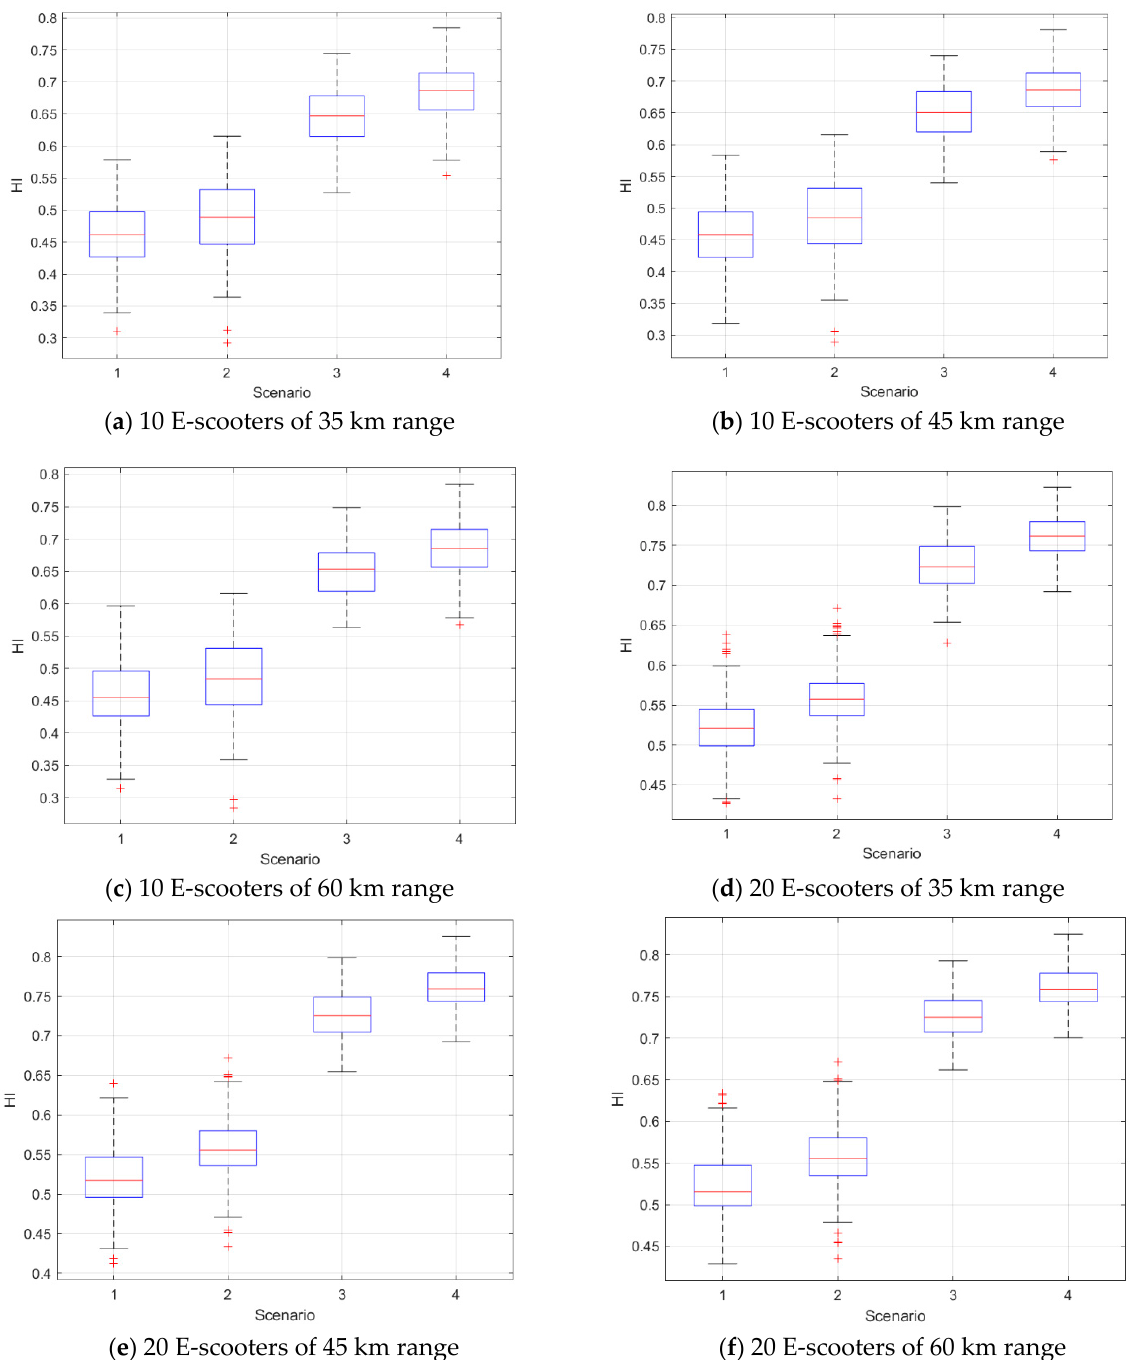
Figure 4. HI results at different scenarios, number of e-scooters at each census tract, and battery ranges. Gamma mixed-effect model is used to test whether the differences in the HI results between the scenarios were statistically significant. As shown in Table 5, scenarios 2,3,4 have a statistically significant larger HI compared to the first scenario. Table 5. P values of the scenario’s indicator variables for the HI models.